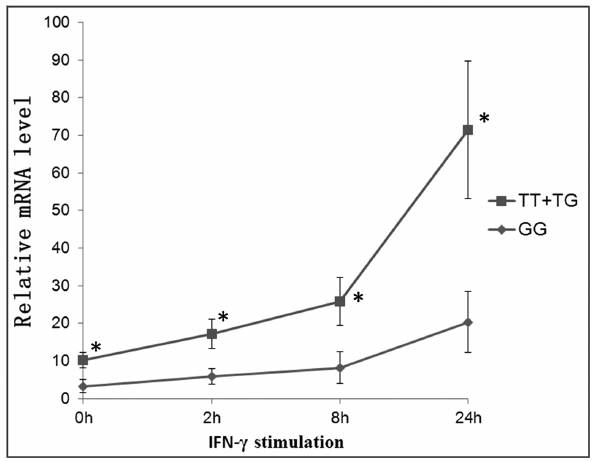
Figure 2. Gene expression analysis of IFITM3 . The relative mRNA expression levels of IFITM3 were displayed according to genotypes of rs3888188: Data are shown as the mean determinations 6 standard deviation (SD) and are representative of three independent experi- ments. Significant difference was defined as a P-value , 0.05 by two- tailed unpaired t test. * indicates a significant difference as compared to GG genotype.